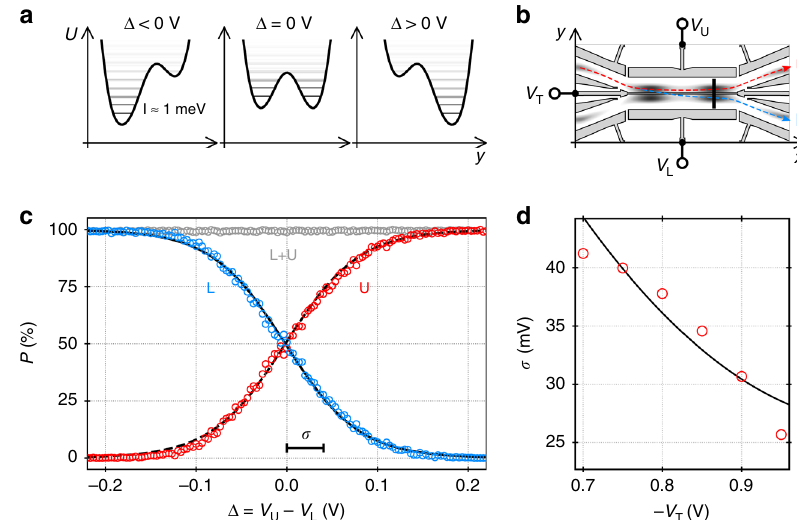
Fig. 2 Directional-coupler operation. a Schematic slices along the double-well potential, U . The horizontal lines represent the eigenstates in the moving QD, whereas the grey shading of the energy levels indicates the exponentially decreasing occupation. b Schematic showing the QDs that are formed by the SAW in the coupling region with additional indications of the surface gates and the transport paths. The black vertical bar indicates the positions of the aforementioned potential slices. c Probability, P , to end up in the upper (U) or lower (L) quantum rail for different values of potential detuning, Δ . The lines show a fi t by a Fermi function providing the scale parameter, σ . d Transition widths, σ , for different values of the tunnel-barrier voltage, V the course of a stationary, one-dimensional model of the partitioning